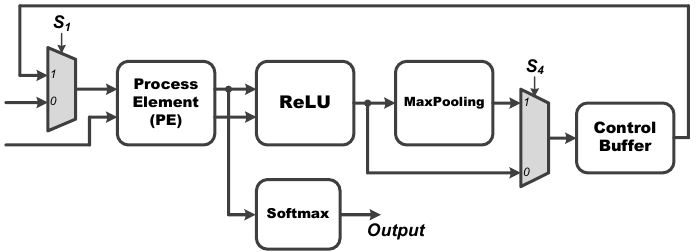
Figure 1. The schematic block diagram of the entire flow of the proposed CNN algorithm for ECG heart beat classification.